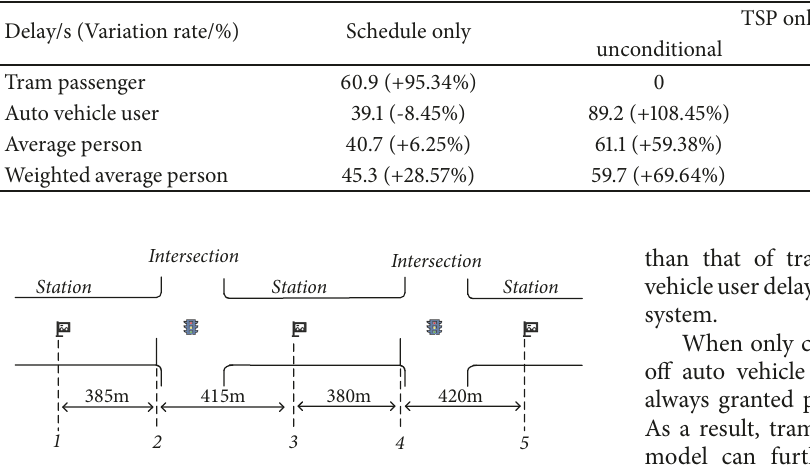
Figure 6: The layout of the tramline in the numerical case.